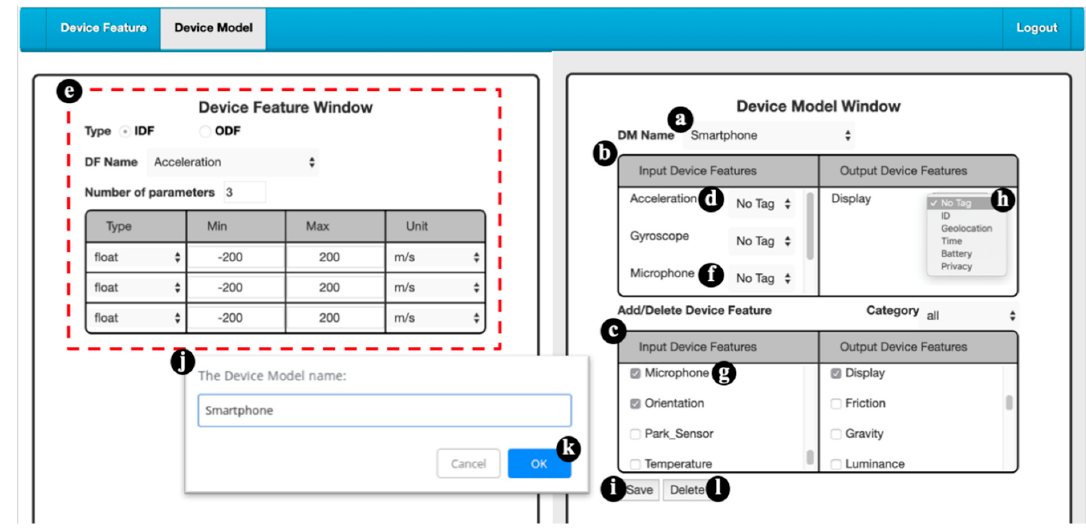
Figure A7. Device model modification.